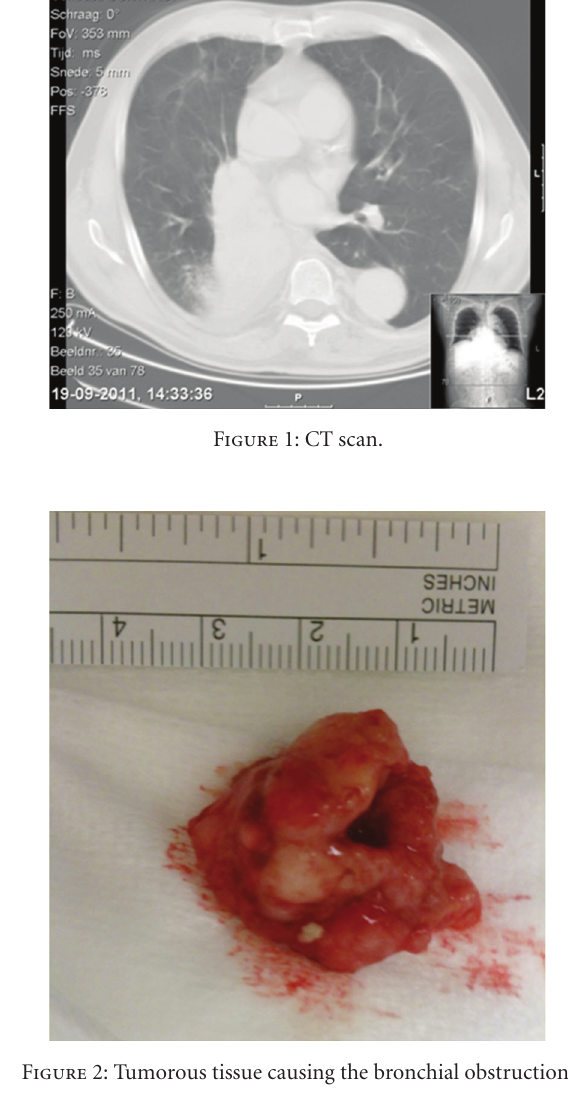
Fibreoptic bronchoscopy showed obstruction of the left main bronchus with a chunk of tissue (Figure 2). A rigid bronchoscopy was performed, and the obstructing tissue was removed using a gripping device. Directly after this maneu- ver, the patient could be ventilated properly again. Oxy- gen saturation levels and arterial blood pressure increased rapidly to normal